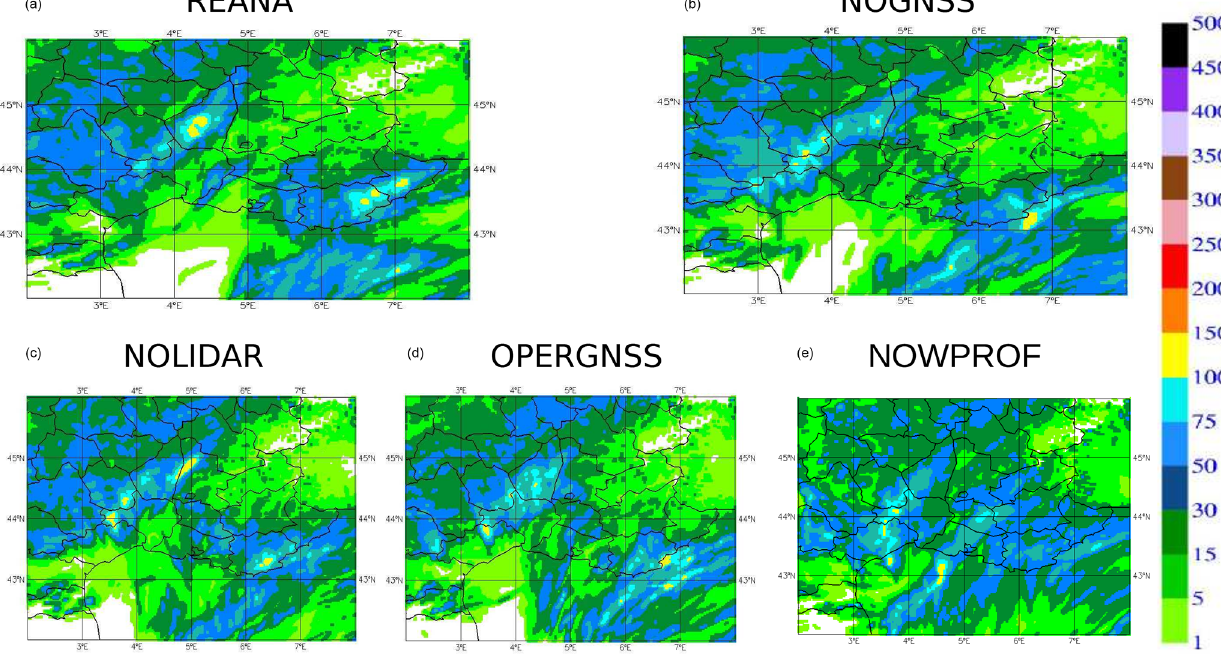
Figure 18. Same as Fig. 17 but for 24h accumulated precipitation forecasted by (a) REANA, (b) NOGNSS, (c) NOLIDAR, (d) OPERGNSS and (e) NOWPROF experiments, from the 6 to 30h forecast